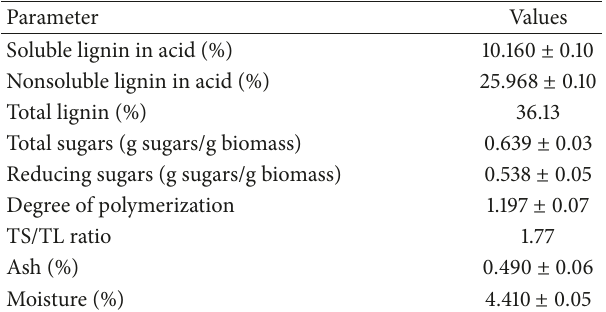
Table 2: Chemical composition of the cellulose-based material. Parameter Values Soluble lignin in acid (%) 10.160 ± 0.10